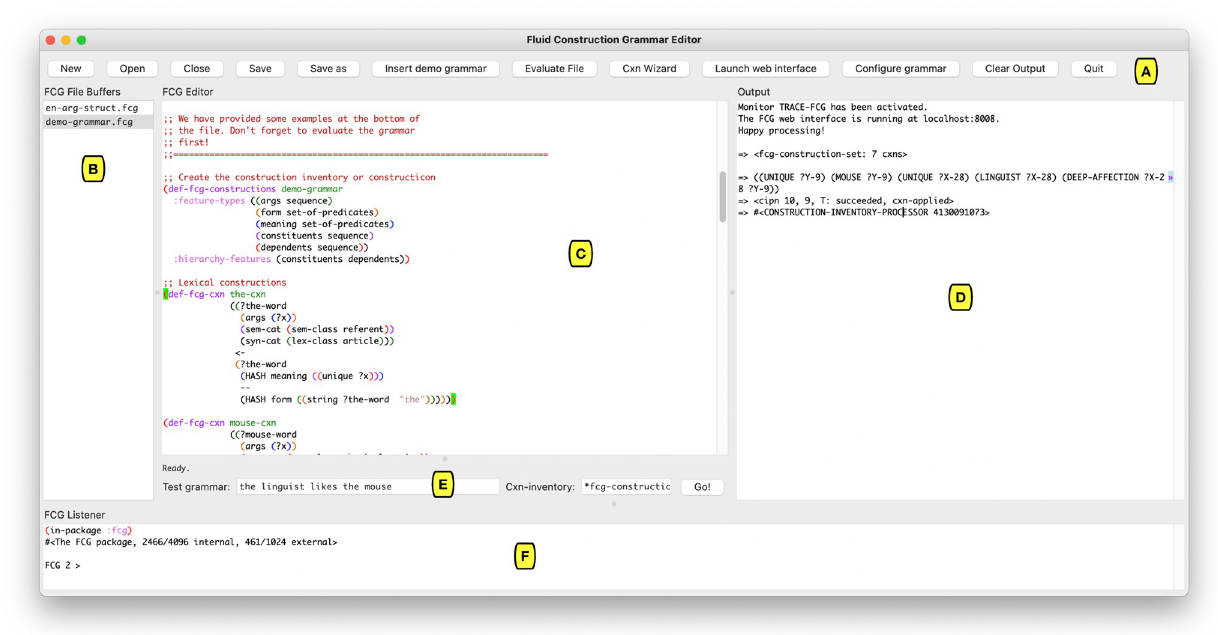
Fig 1. Overview of the graphical user interface. The FCG Editor’s main interface, featuring its toolbar (A), buffer overview list (B), editor pane (C), output pane (D), testing pane (E) and listener pane (F).